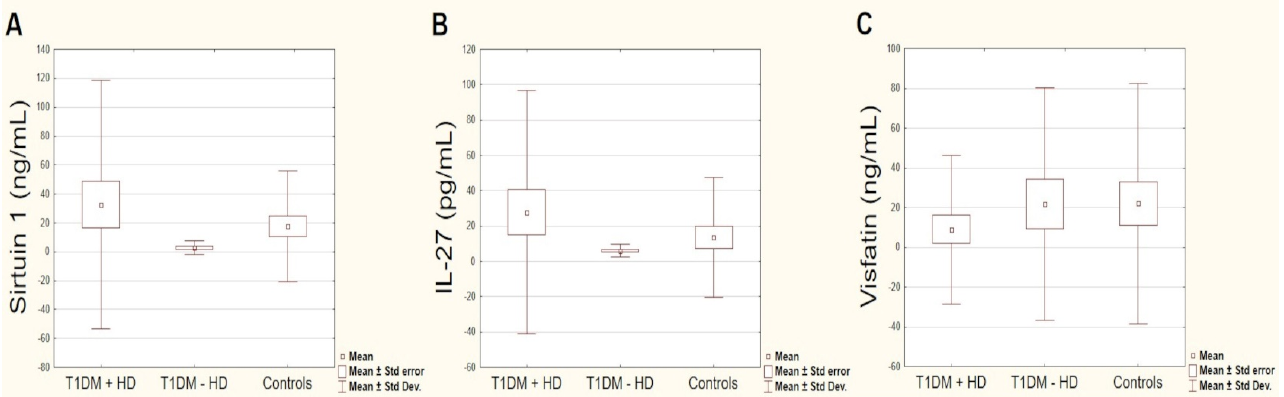
Figure 3. ( A ) Sirtuin 1 serum levels, ( B ) IL-27 serum levels, and ( C ) visfatin serum levels for each sample group in the study population.